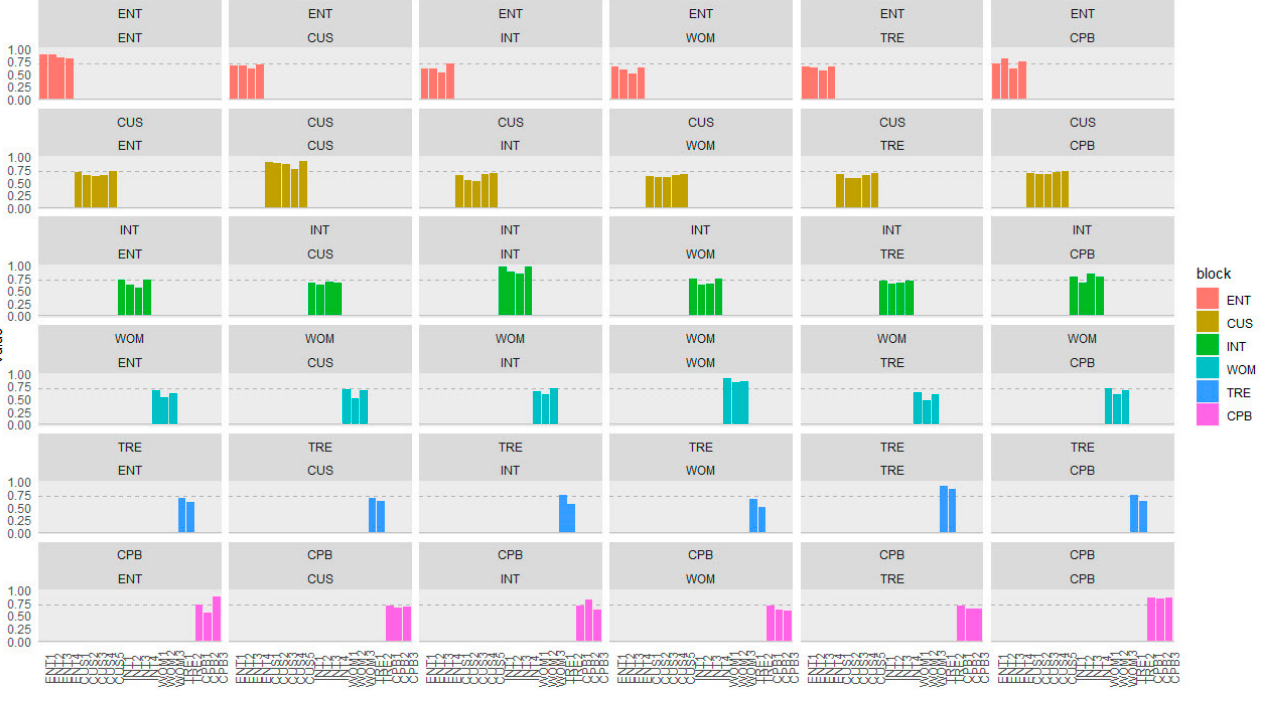
Figure 3. Graphical cross-loadings with R.